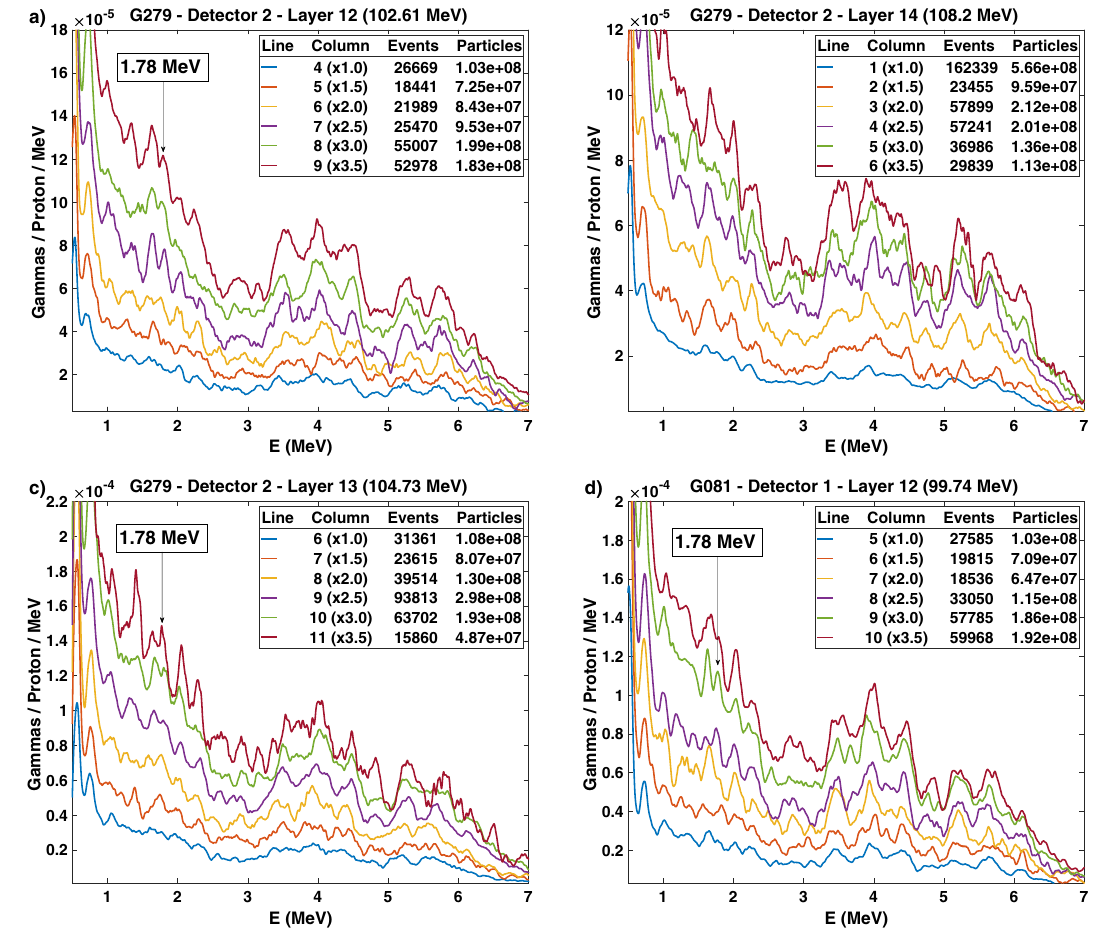
Figure 7. Energy spectra from the irradiation of the prostate phantom by an AO plan. ( a ) Detector 2 detects a 7 1.78 MeV silicon line starting at column 6 of the IEL 12 (102.6 MeV) during irradiation with 8.4 × 10 protons, thus indicating the entrance of protons into the ERB. ( b ) The real plan without overlap with the ERB presents no silicon energy peaks for the last columns of IEL 14 (108.2 MeV). ( c ) Another measurement separated in time by one month also shows a 1.78 MeV silicon peak for the AO beam overlapping with the ERB. ( d ) A symmetric ◦ configuration with an AO plan for an 81 gantry angle results in the detection of prompt gamma radiation by the first detector with the same energy lines of